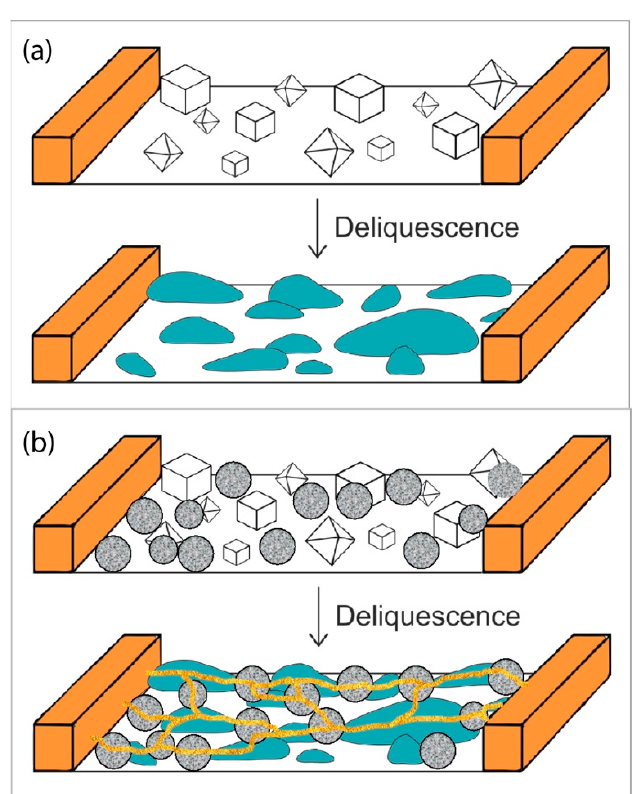
Figure 7. ( a ) Scheme showing the phenomenology behind the results of the conductance measurements obtained for pure saline samples ( b ) and for mixed saline and soot samples. The side bars represent a pair of electrodes of a filter housing in the AEC and the area between them is an exemplification of the laboratory generated aerosol samples deposited on a PTFE filter, before and after the deliquescence of the saline components. Gold lines represents the occurring bridging in panel B.